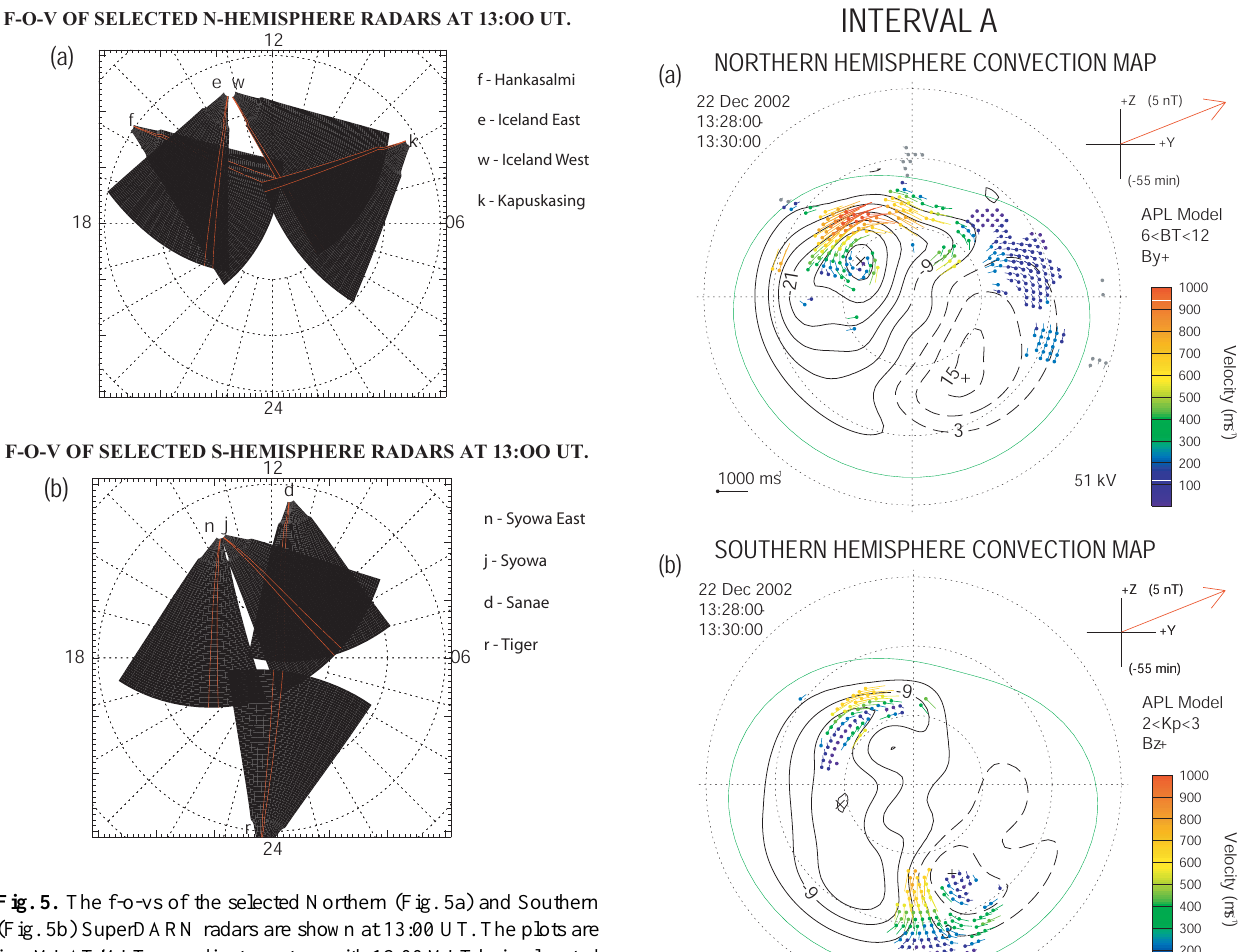
lobe cell, the precipitation being associated with a transpo- lar auroral arc. Lyons et al. (1996) also observed precipi- tating electrons with similar energies in a region of negative electric field divergence in the centre of a circular convection cell (i.e. a region of clockwise flow as viewed from above the Northern Hemisphere as in the present case), which the authors identified as being associated with a polar-cap arc. The spacecraft remains within the polar-cap arc region until 13:31:25 UT, although it does observe two narrow void regions during this time. Between 13:31:25 UT